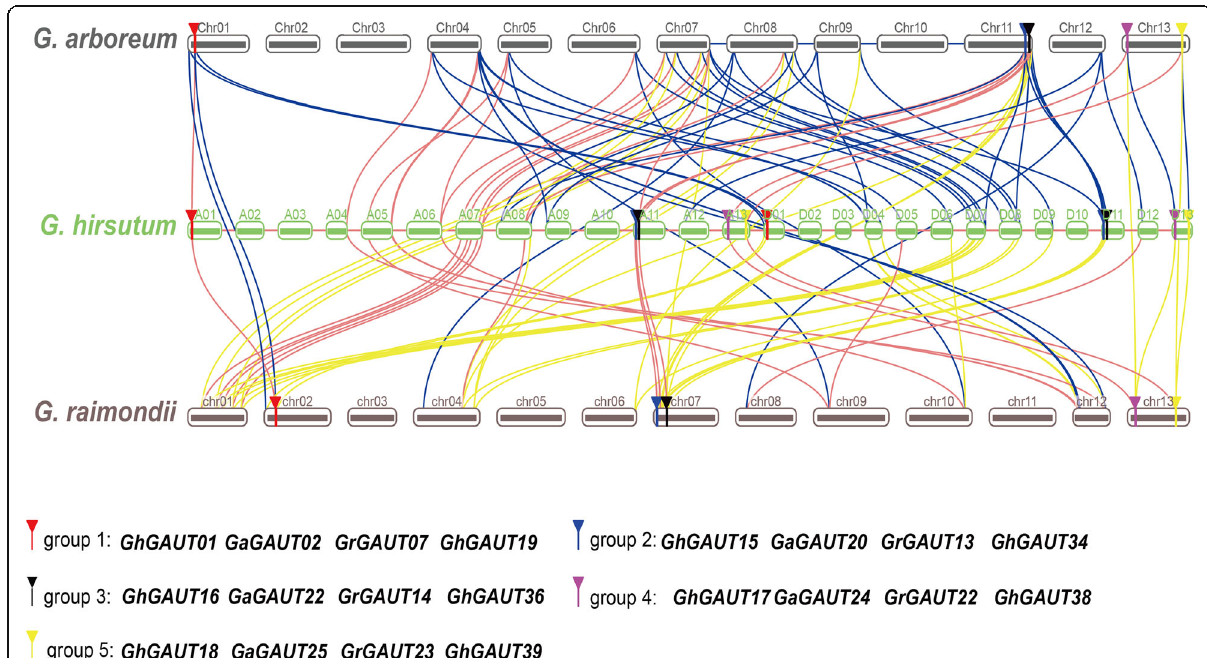
Fig. 3 Collinearity of galacturonosyltransferase genes in G. arboretum , G. hirsutum and G.